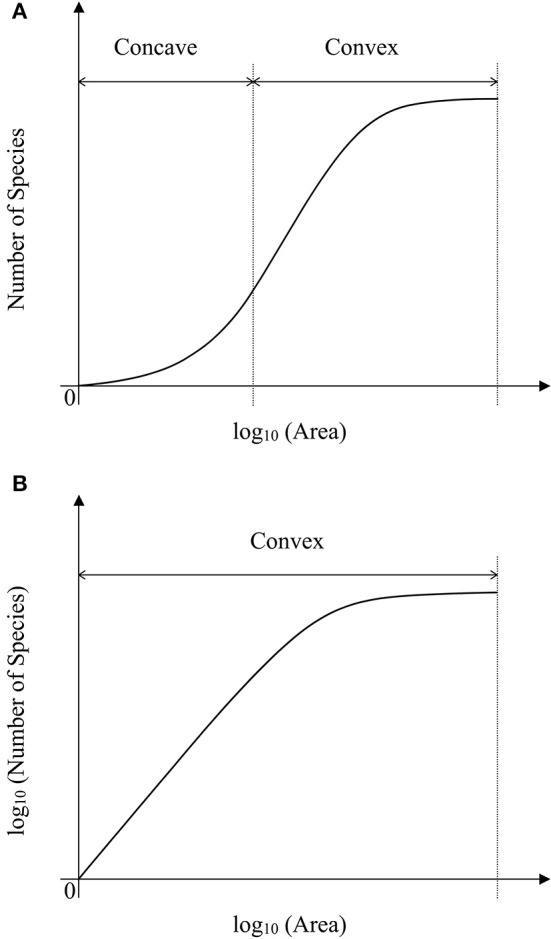
(A) Is the schematic diagram for log10 (Area)−Number of Species. (B) Is the schematic diagram for log10 (Area)−log10 (Number of Species).